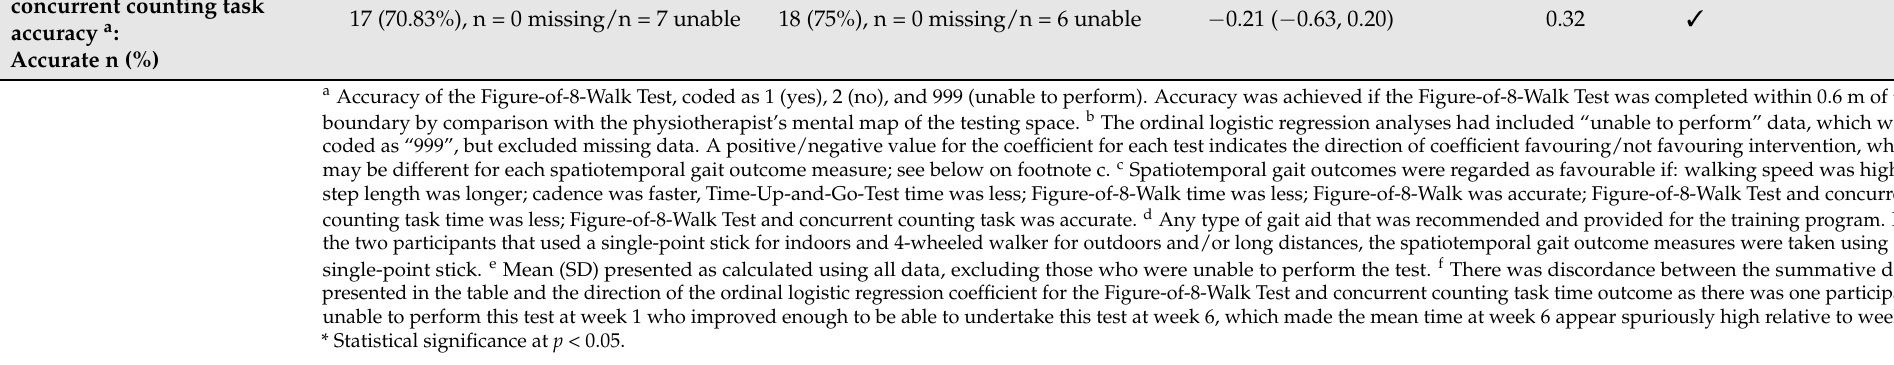
Figure-of-8-Walk Test